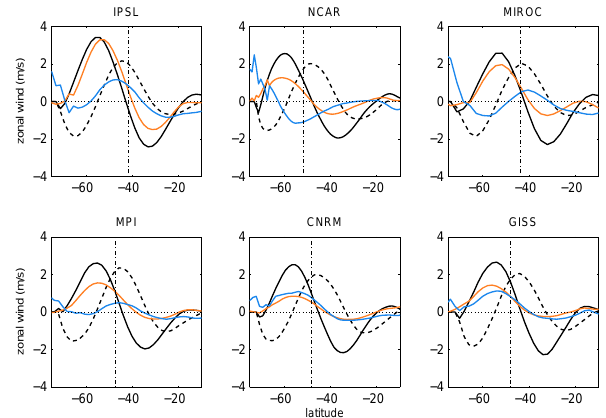
Fig. 4. Latitudinal structure of the variability and response of the zonal-mean zonal wind at 850-hPa for all the models. Black lines: anomalies for 1 σ of the first (solid line) and second (dashed) EOF of the zonal-mean zonal wind in the PI simulation. Colors: mean PI– LGM (blue) and RCP–PI (red) difference. The vertical line indicates the jet position in the PI